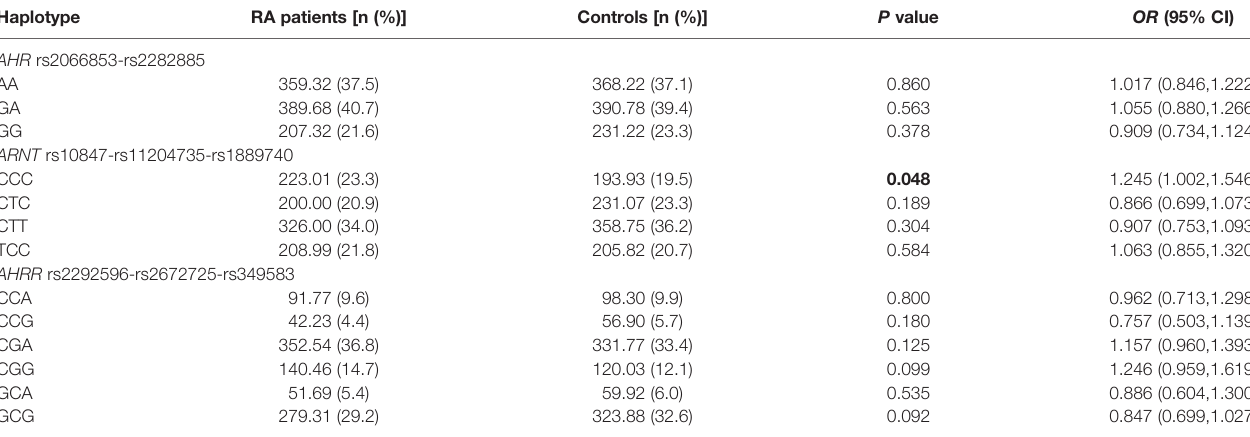
TABLE 4 | Haplotype analysis of AHR, ARNT, AHRR genes in RA patients and controls. Haplotype RA patients [n